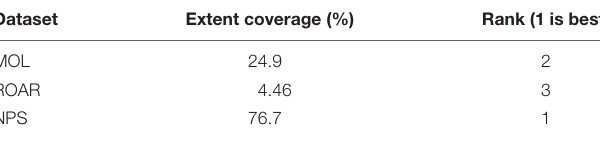
TABLE 2 | Spatial extent, percentage of the desired extent covered, and